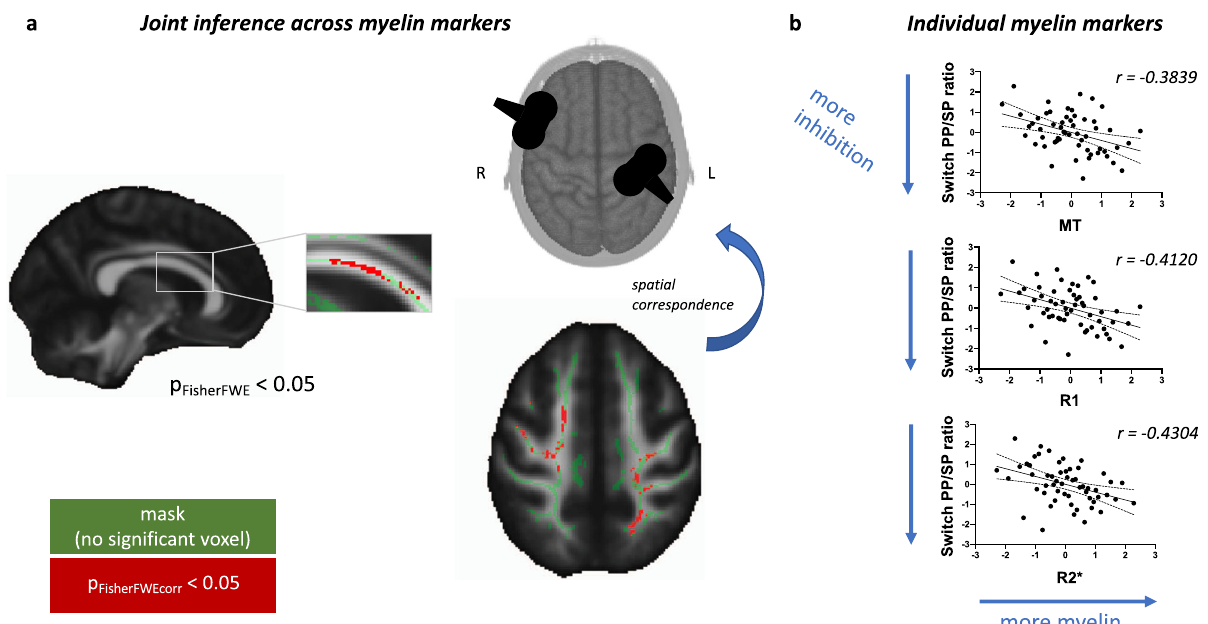
Fig. 2 Multimodal joint inference reveals concordant relationships between interhemispheric cortico-cortical inhibition and myelin markers across modalities. a Result of joint inference across myelin markers. Clusters of signi fi cant voxels are shown in red (peak p FisherFWE = 0.016), overlaid on the white matter skeleton (green). Signi fi cance threshold for joint inference Fisher test is set at 0.05 after correcting for family-wise error correction. b Correlations between switch PP/SP ratio (paired pulse/single pulse ratio from ppTMS) and individual myelin markers. Each data point is a single participant; scatterplots and Spearman correlation effect sizes are presented for post hoc visualisation of the correlations, rather than for statistical